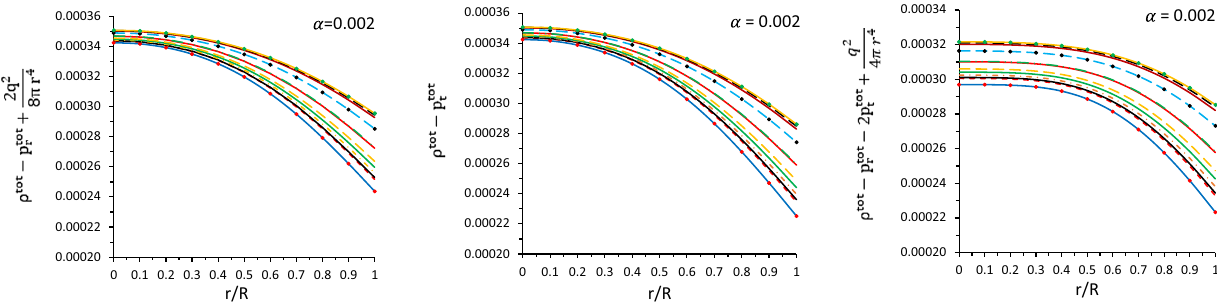
Fig. 6 The behavior of total energy density ( ρ tot ) and total anisotropy ( (cid:2) tot ) versus radial coordinate r / R by taking the numerical values of the constants a = 0 . 003, b = 0 . 0000053, β = 1 . 1, and γ = − 0 . 001